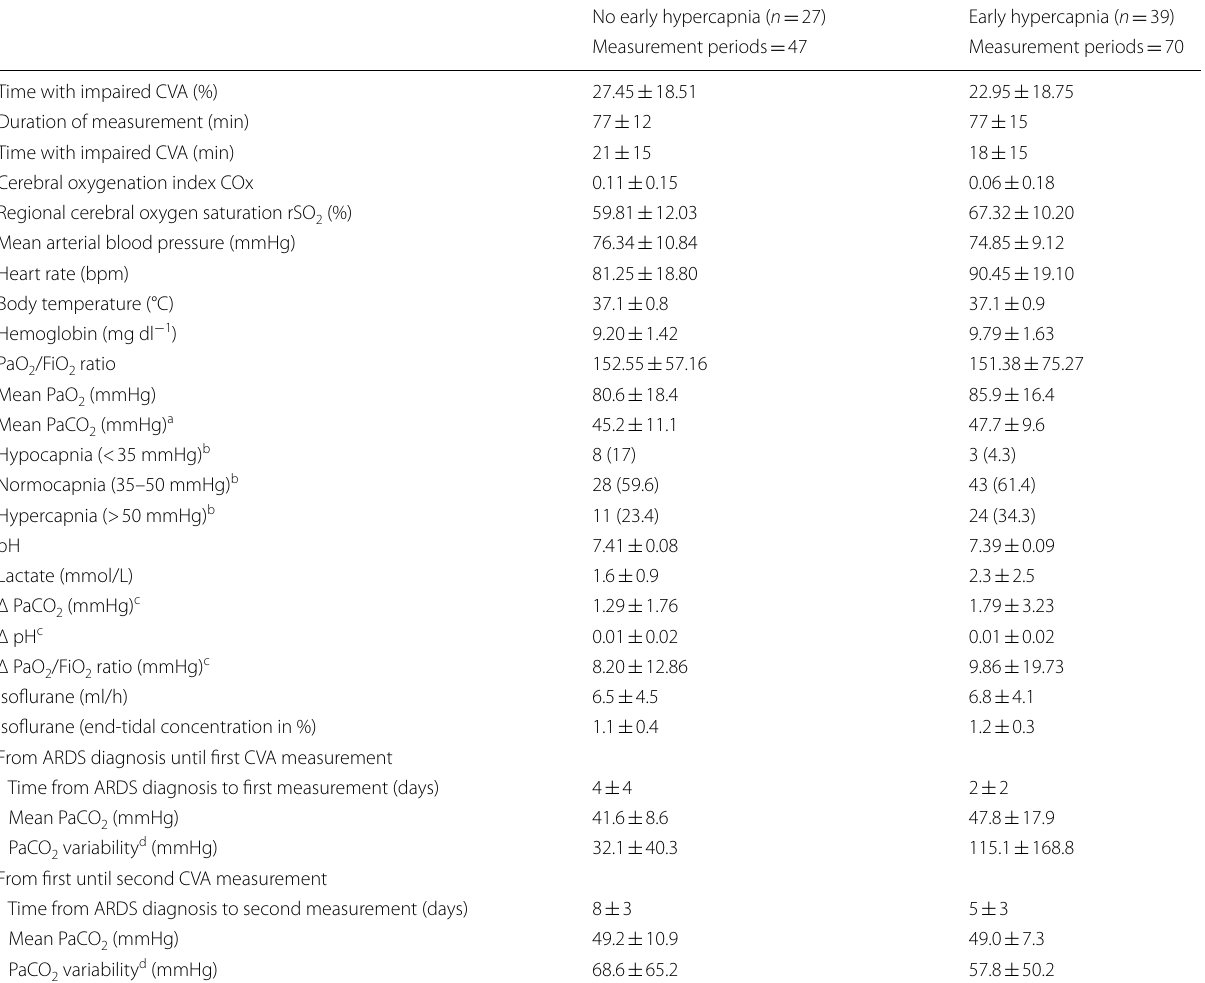
Table 2 Hemodynamic parameters and selected results from blood gas analyses during the measurement of cerebrovascular autoregulation